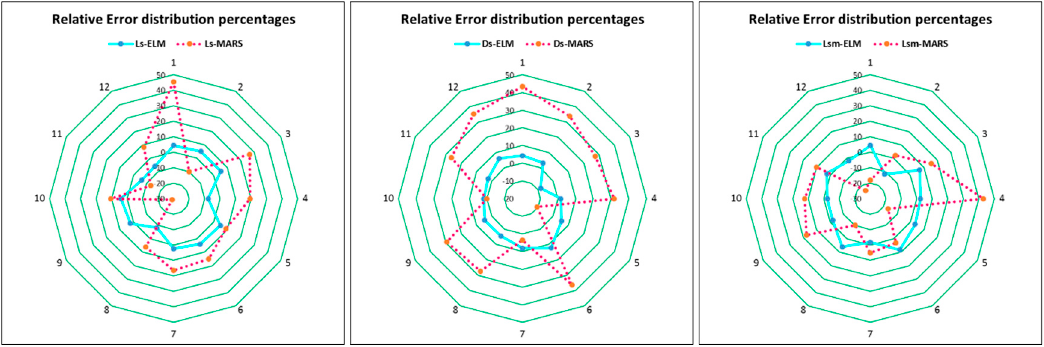
Figure 7. The relative error distribution percentages during validation of ELM and MARS models using dimensional variables.